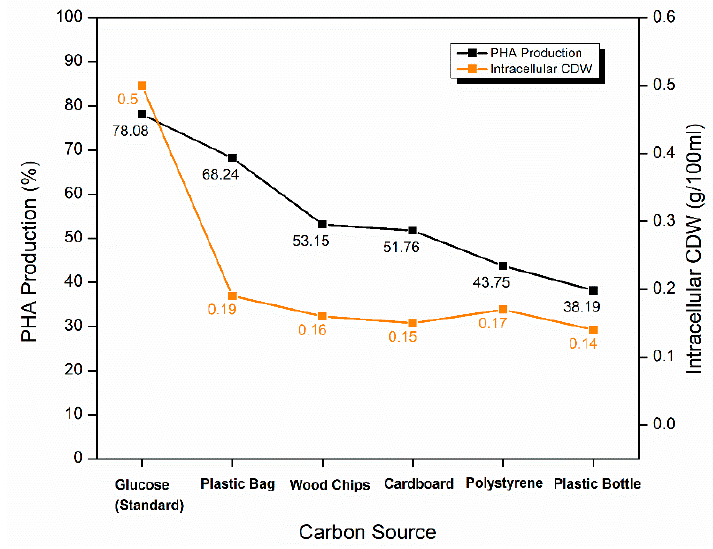
Figure 8. Optimization waste agro-industrial carbon sources for PHA production by S. maltophilia HA-16 with glucose as carbon source.